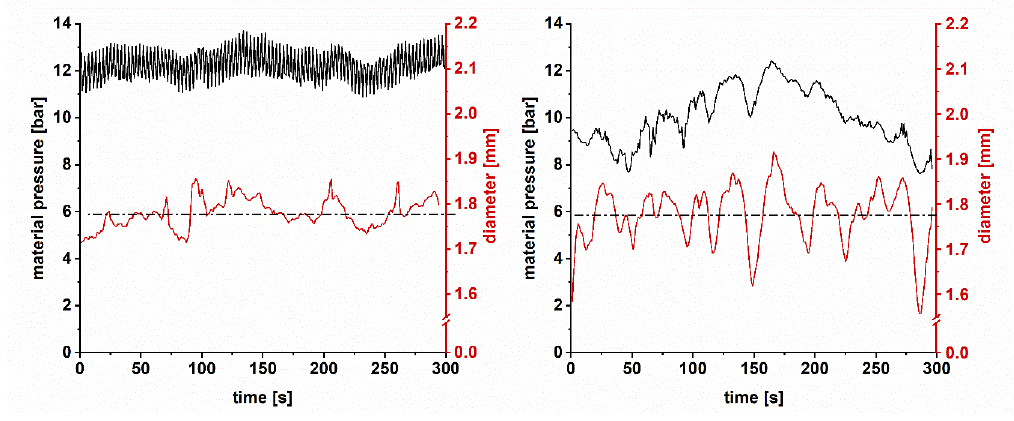
Figure 4. Inline determined material pressure and diameter as a function of time, where a PFR of 5 g / min and a screw speed of 40 rpm ( left ) or 60 rpm ( right ) were applied. The dashed lines mark the mean diameter.